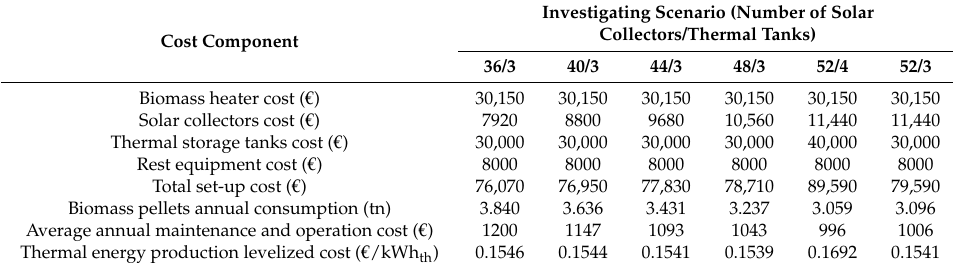
Table 5. Calculation of the thermal energy production annual average levelized